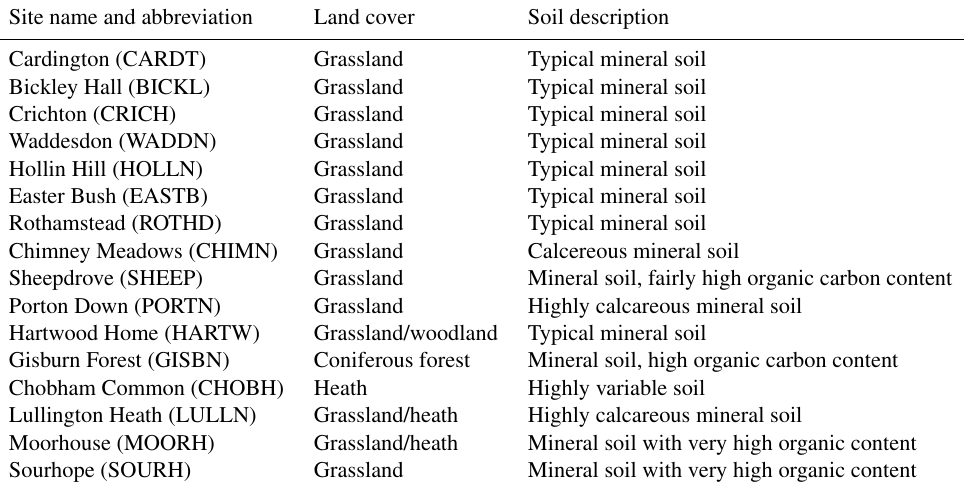
Mineral soil, high organic carbon